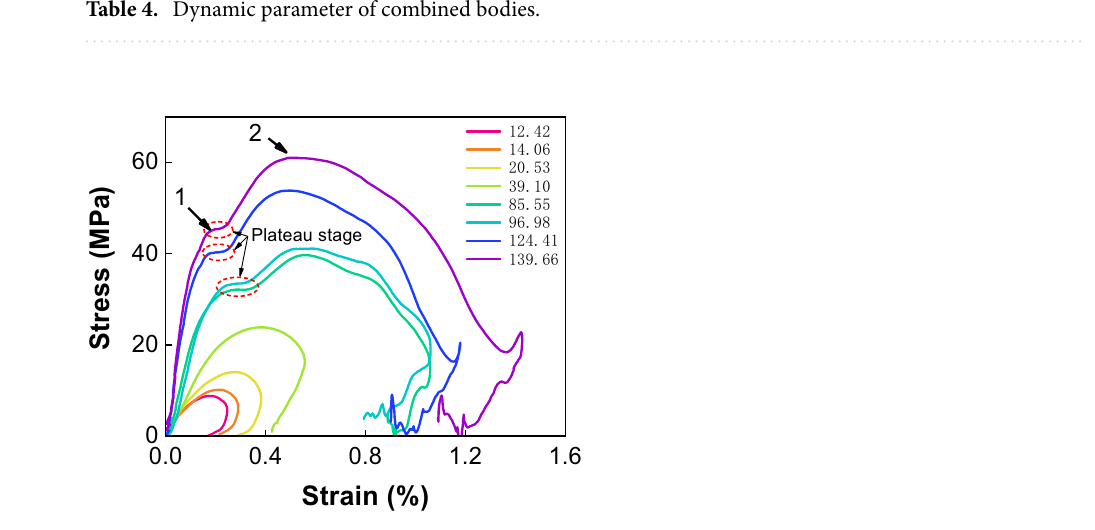
Table 4. Dynamic parameter of combined bodies.